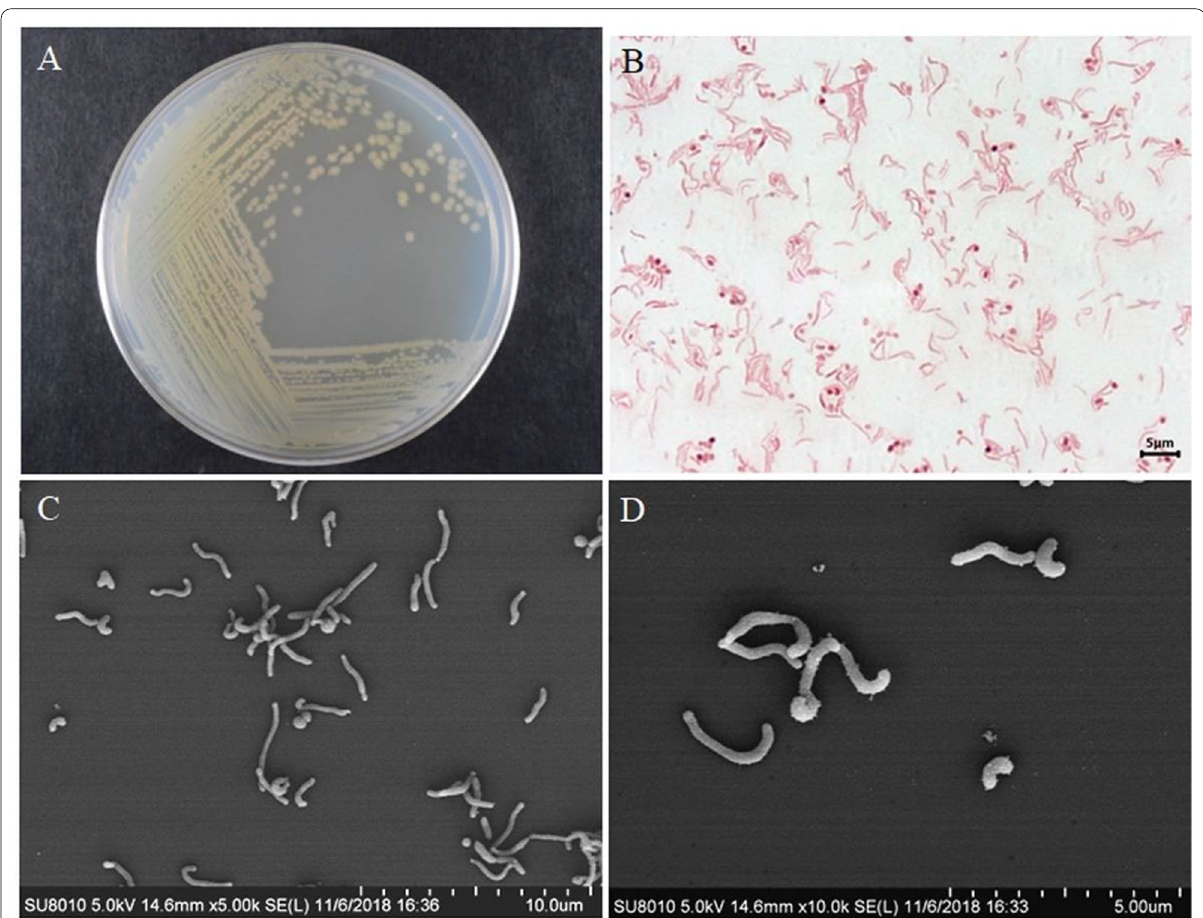
Fig. 3 Morphological observations of strain ALW1. A Colonies of ALW1 cells on 2216E agar plate. B Light microscope observation of strain ALW1. C and D Scanning electron microscope observation of strain ALW1. Bars, 10 μm ( C ) and 5 μm ( D